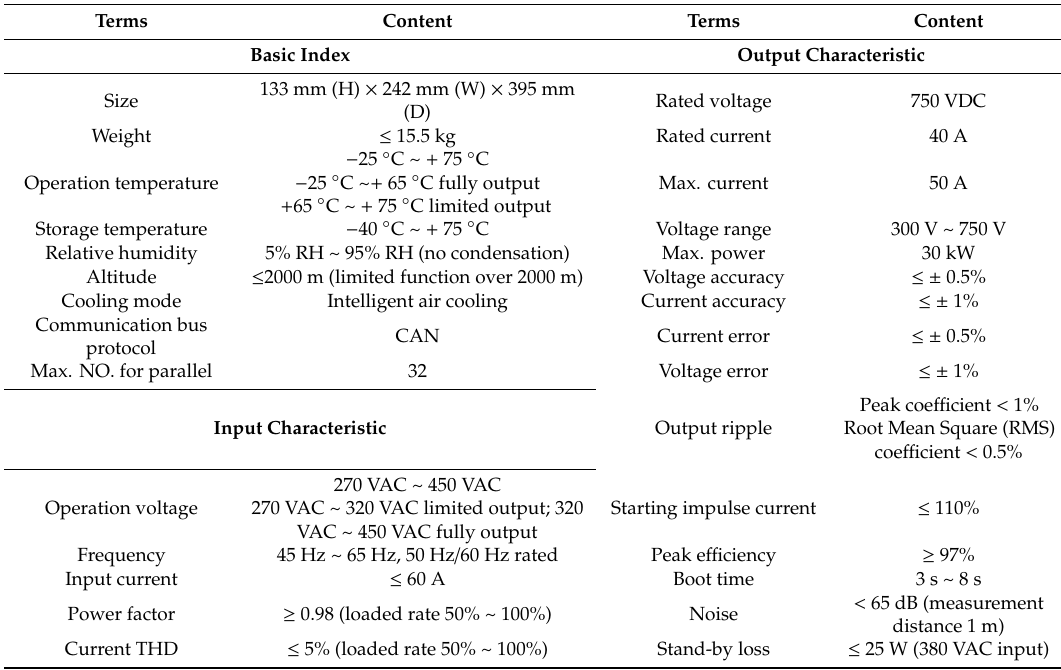
Table 1. Technical specifications of the all-SiC (silicon carbide) power